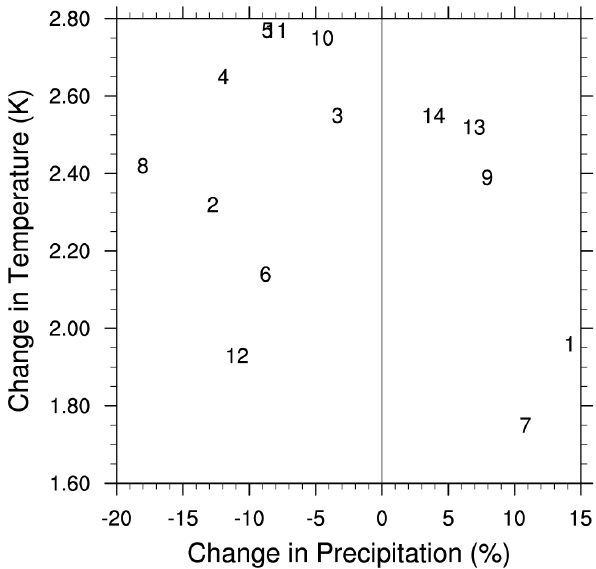
Fig. 4. Future change space for the CMIP3 GCMs that performed adequately and had the necessary data available, numbered by their independence rank. The change is between the mean of 1990–2009 and the mean of